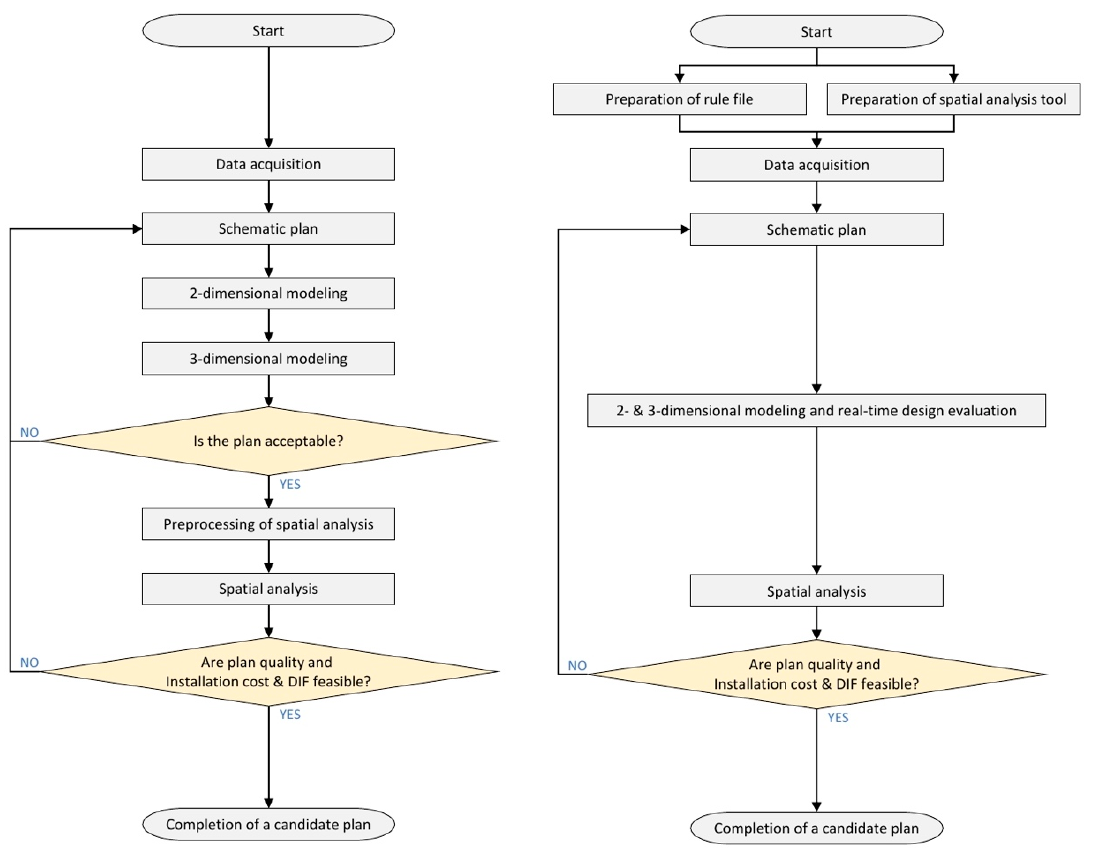
Figure 6. The two methods of infrastructure installation planning in detail: (left) traditional method; and (right) procedural modeling.